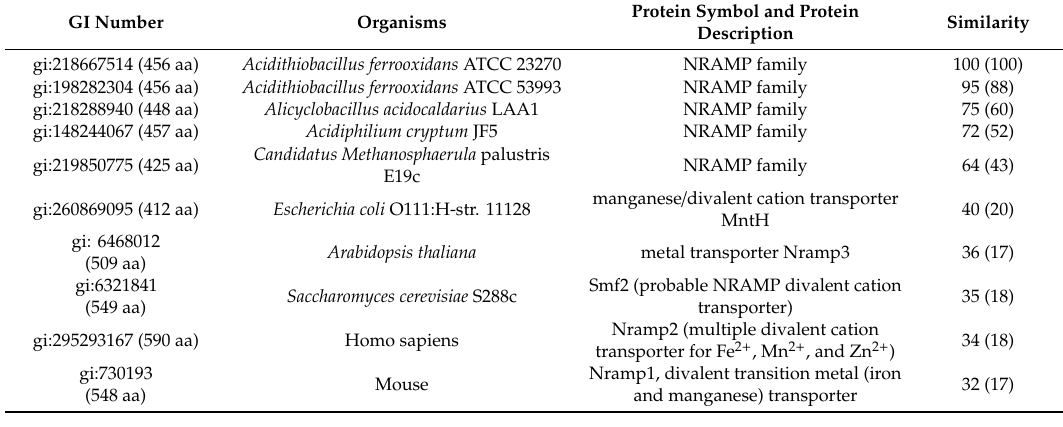
Table 3. Percent similarity and identity (in parentheses) scores were calculated between AFE_2126 from At. ferrooxidans of the Dachang Copper Mine (DC) and Nramp-related proteins.